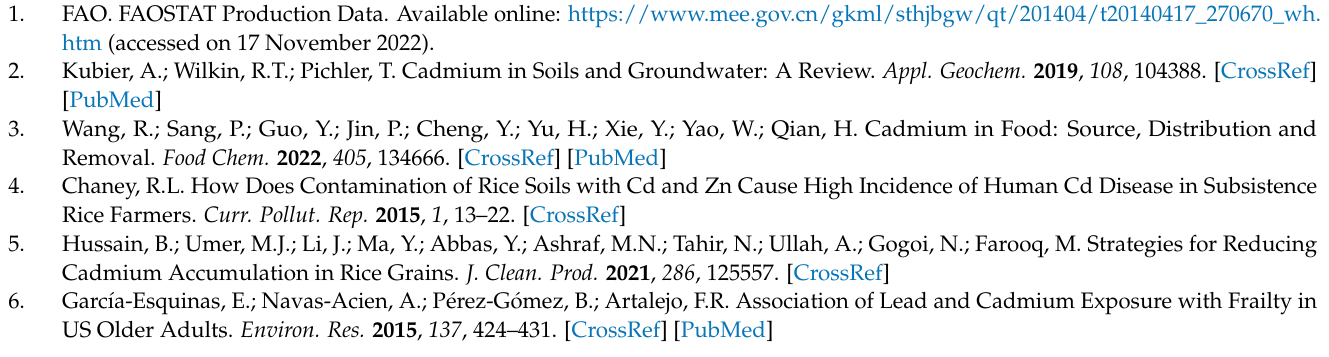
Figure S2: Physicochemical parameters of water and soil; Figure S3: Dynamic changes of physico- chemical indicators in soil; Table S1: Agricultural management records and sampling